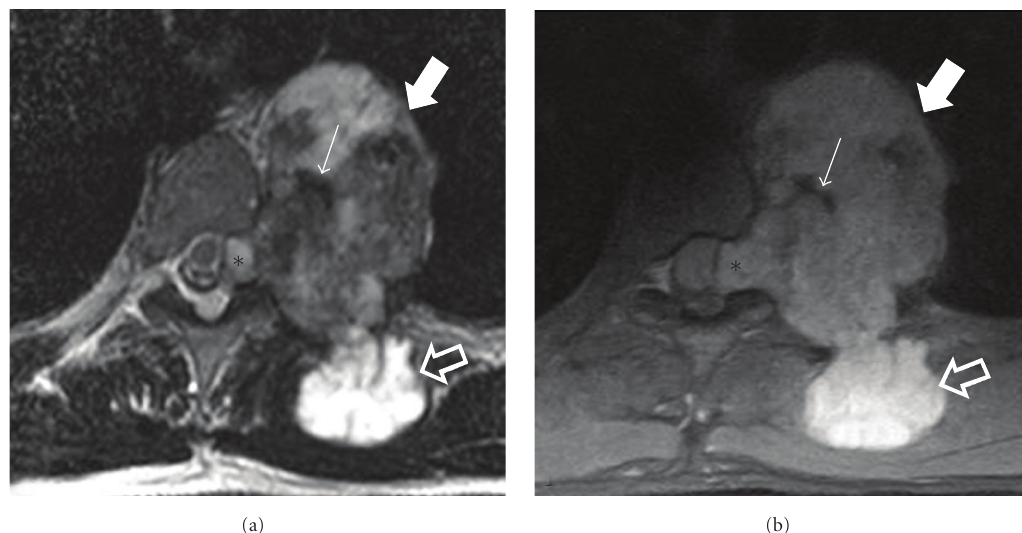
Figure 3: MR imaging of the same patient. The axial T2-w (a) and the axial fat-saturated PD-w (b) MR images show a heterogeneous high intensity mass (thick arrows) with mineralized elements that demonstrate low signal intensity (thin arrow). Note the superficial (open arrows) as well as the neural foraminal extension (asterisks) of the tumor.